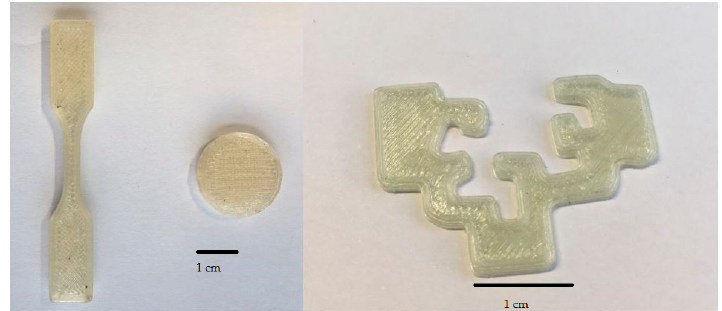
Figure 4. Printed models for PVC/40DINP sample.